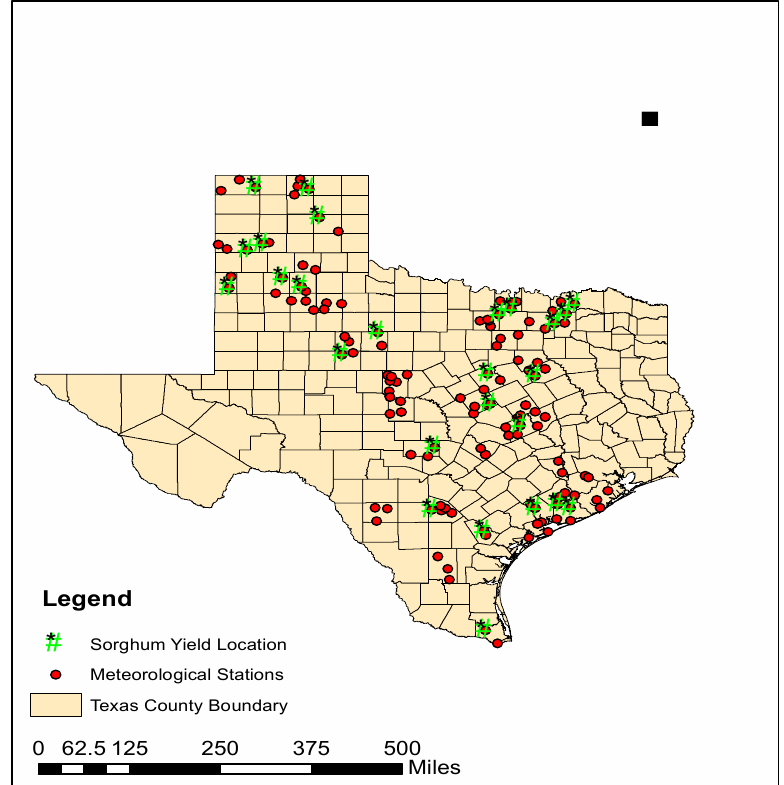
Figure 1. Map showing the location of Meteorological stations and rainfed sorghum cultivated location.